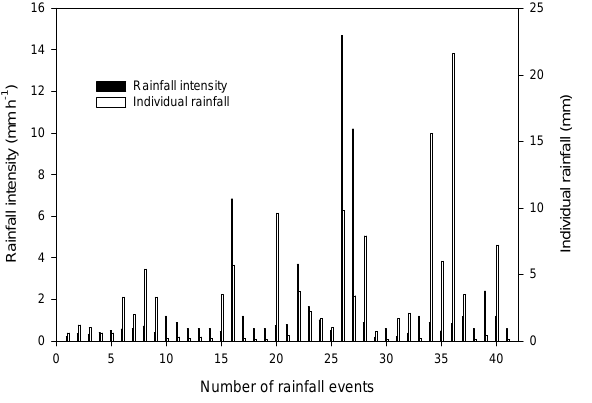
Fig. 2. Rainfall intensity and rainfall amount for 41 individual events during 2008 at the experimental site.